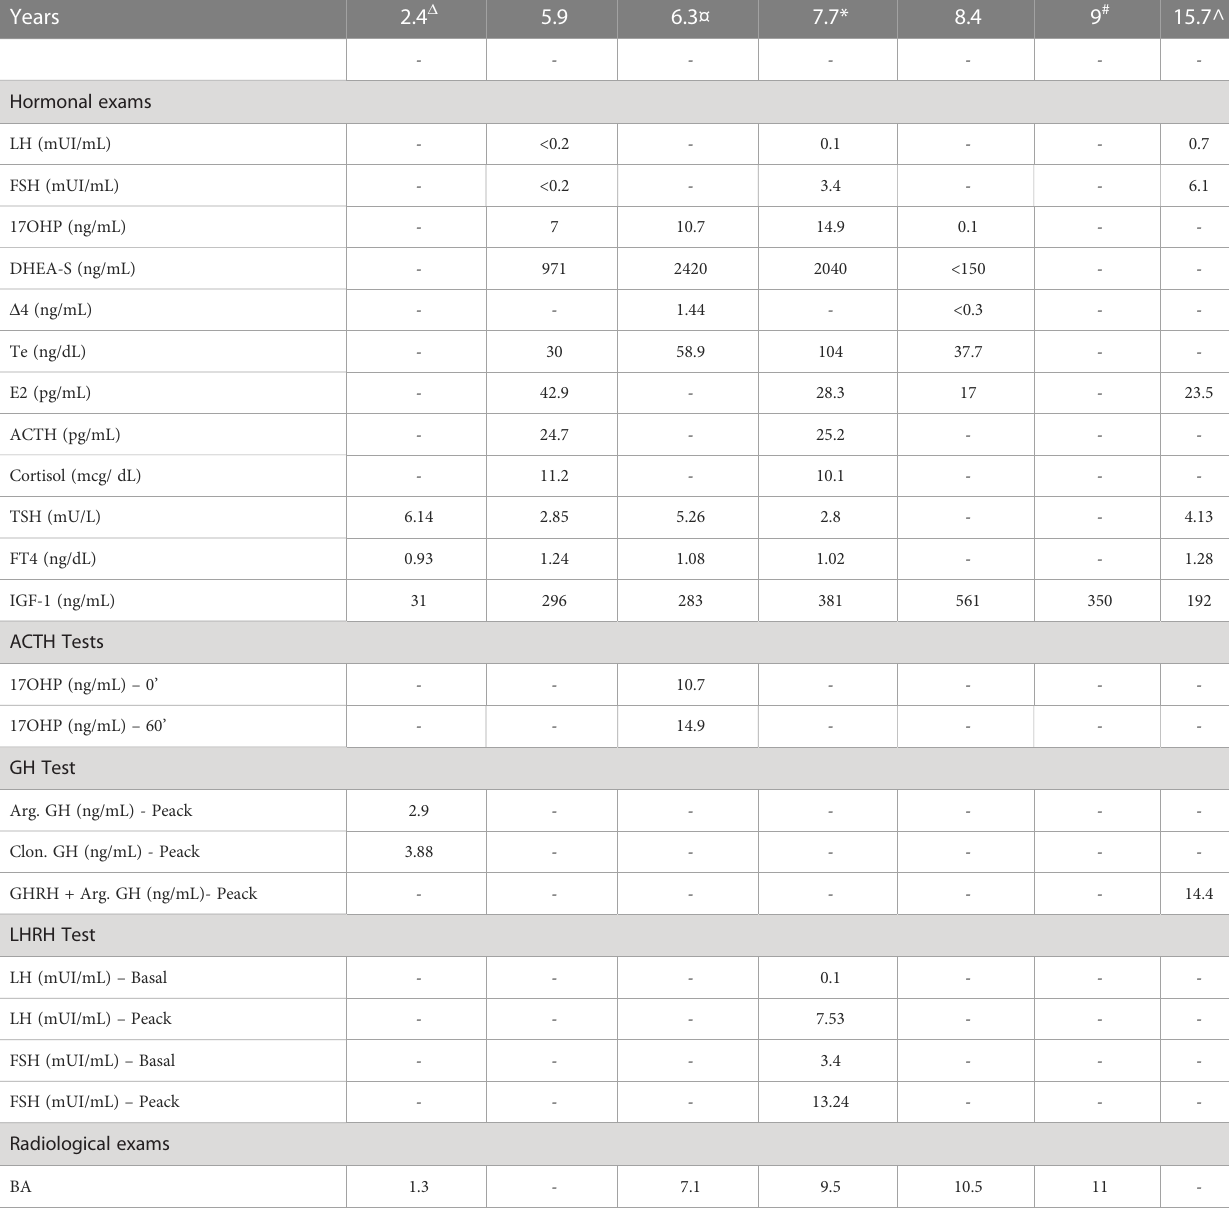
TABLE 2 Hormonal and radiological exams during endocrinological follow